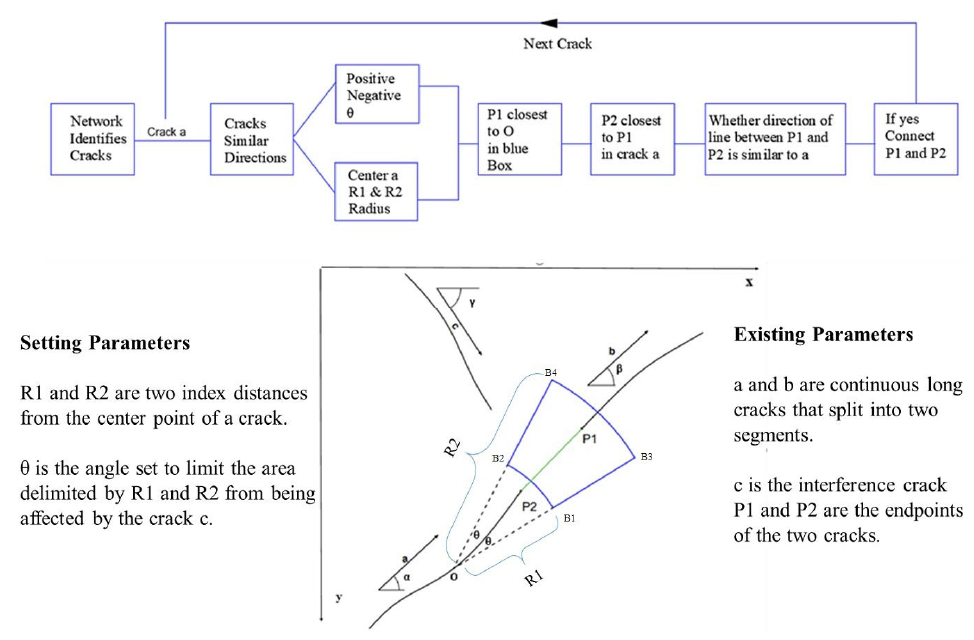
Figure 7. Schematic of scratch region growth.